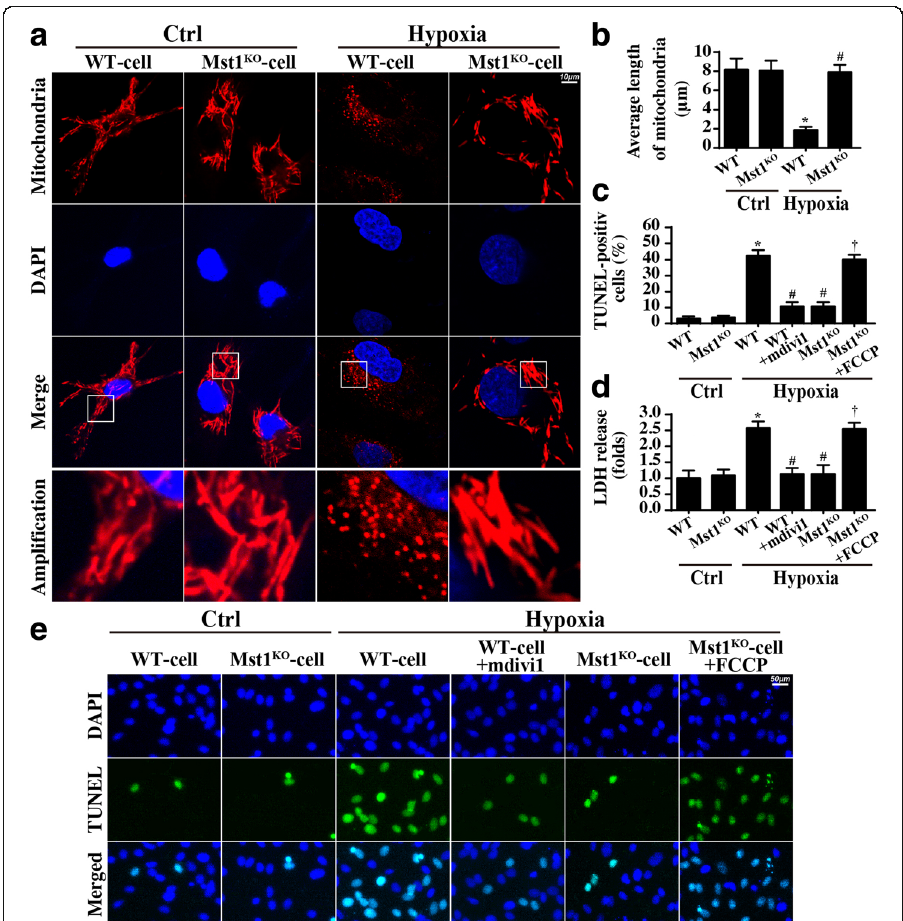
Fig. 5 Mst1 controlled cellular apoptosis via mitochondrial fission. a The mitochondria of wild-type cells (WT-cell) and Mst1-knockout cells (Mst1 KO -cell) were stained with Tom20 under control (Ctrl) and hypoxia conditions and mitochondrial fission was measured. b The average length of mitochondria was quantified. c and e The TUNEL assay was used to label the apoptotic cells. d The LDH release assay was carried out to measure the cardiomyocyte damage with mitochondrial fission activation and inhibition. * p < 0.05 vs. ctrl group, # p < 0.05 vs. WT-cell+hypoxia, † p < 0.05 vs. Mst1 KO